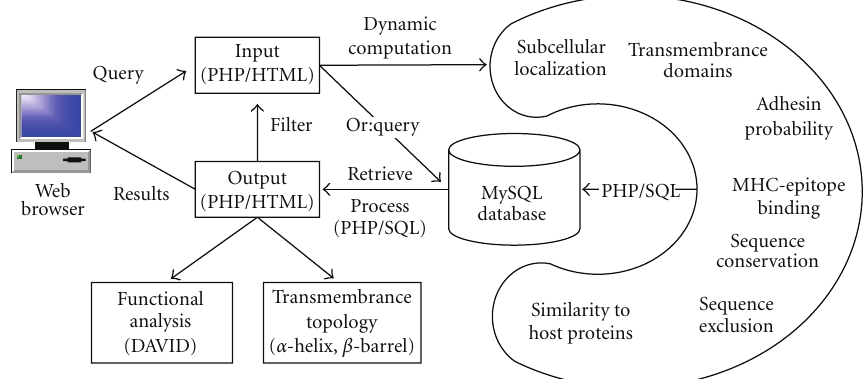
Figure 1: The Vaxign algorithm